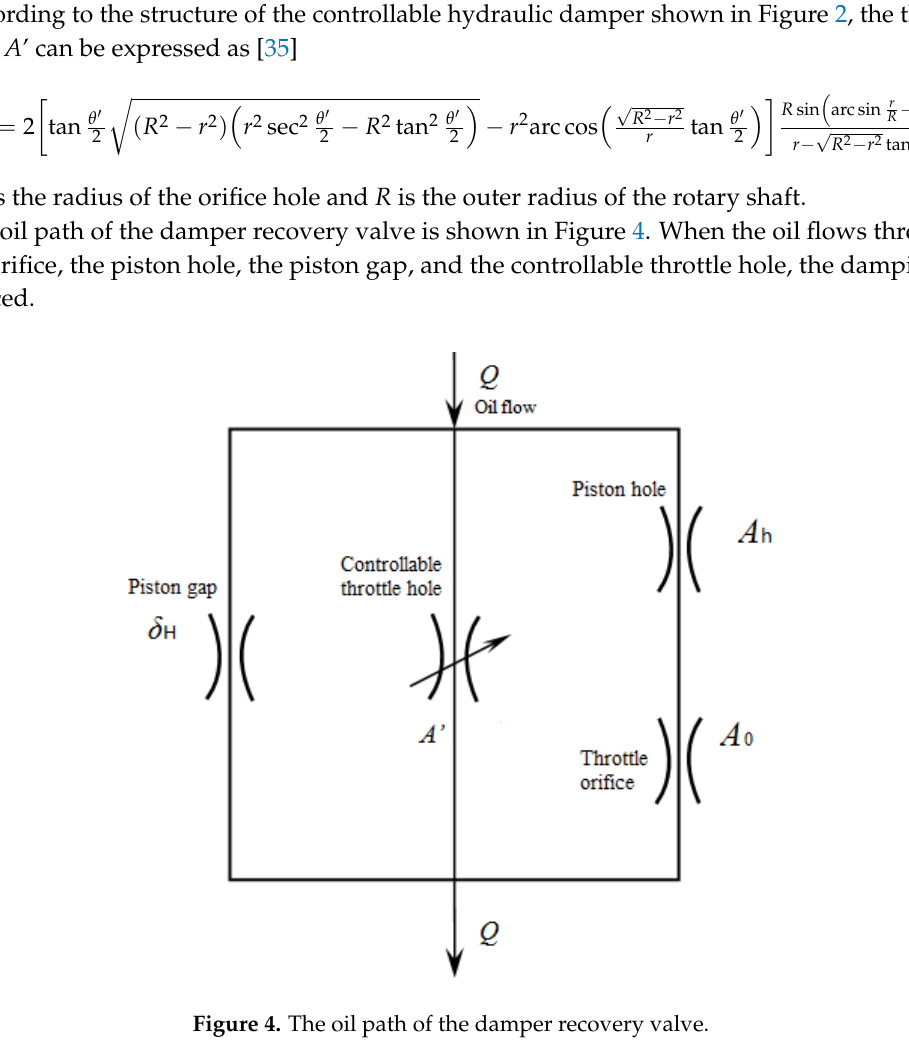
Figure 4. The oil path of the damper recovery valve.